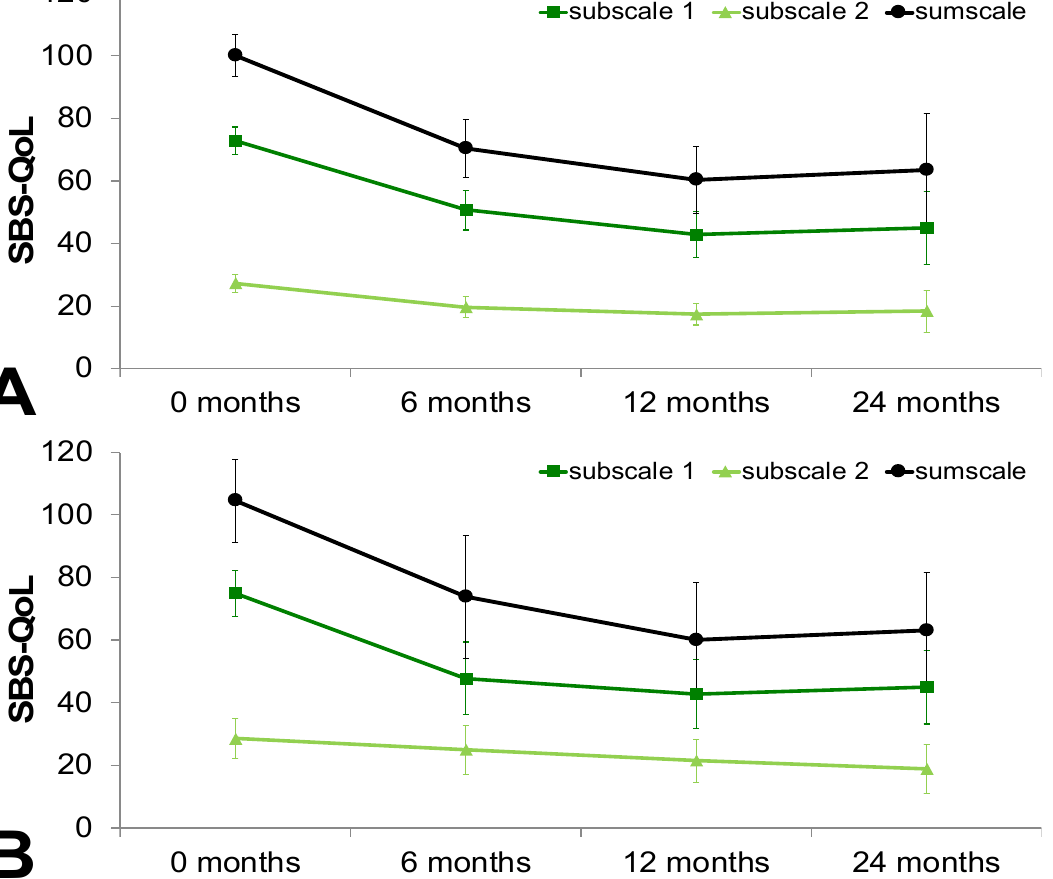
Figure 1. Quality of life as determined by the SBS–QoL. Quality of life improved within the study period in total cohort ( A ) and a subgroup excluding patients who were weaned off parenteral nutrition ( B ). Data presented as mean ± standard deviation. SBS-QoL, Short Bowel Syndrome-Quality of